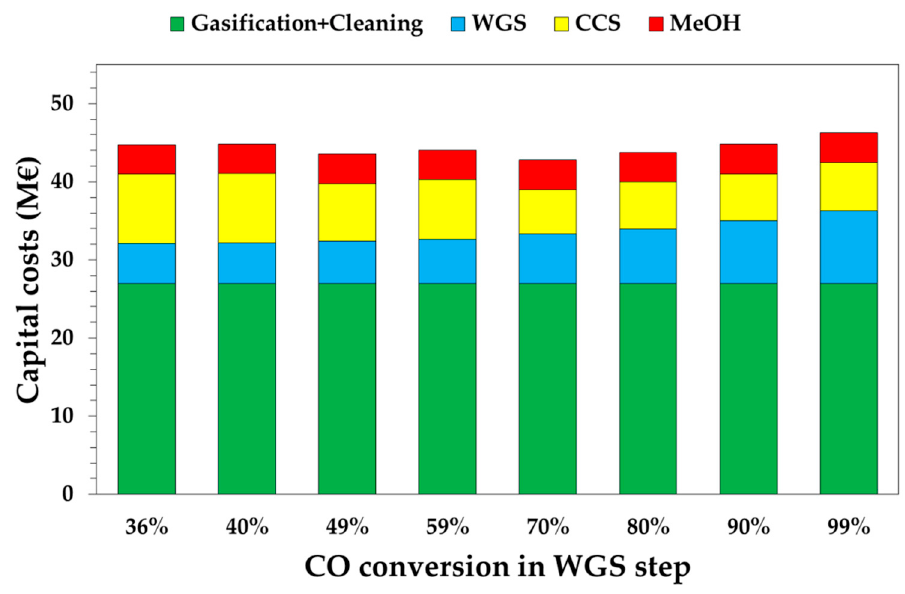
Figure 5. Capital costs as a function of WGS conversion. Gasification includes syngas cleaning.